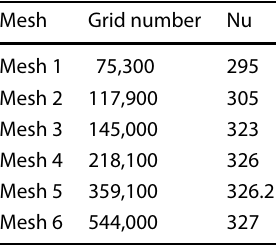
Table 4 Grid independence